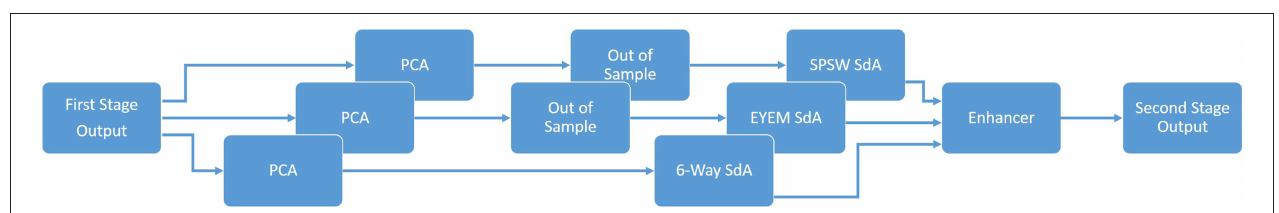
FIGURE 7 | An overview of the second pass of